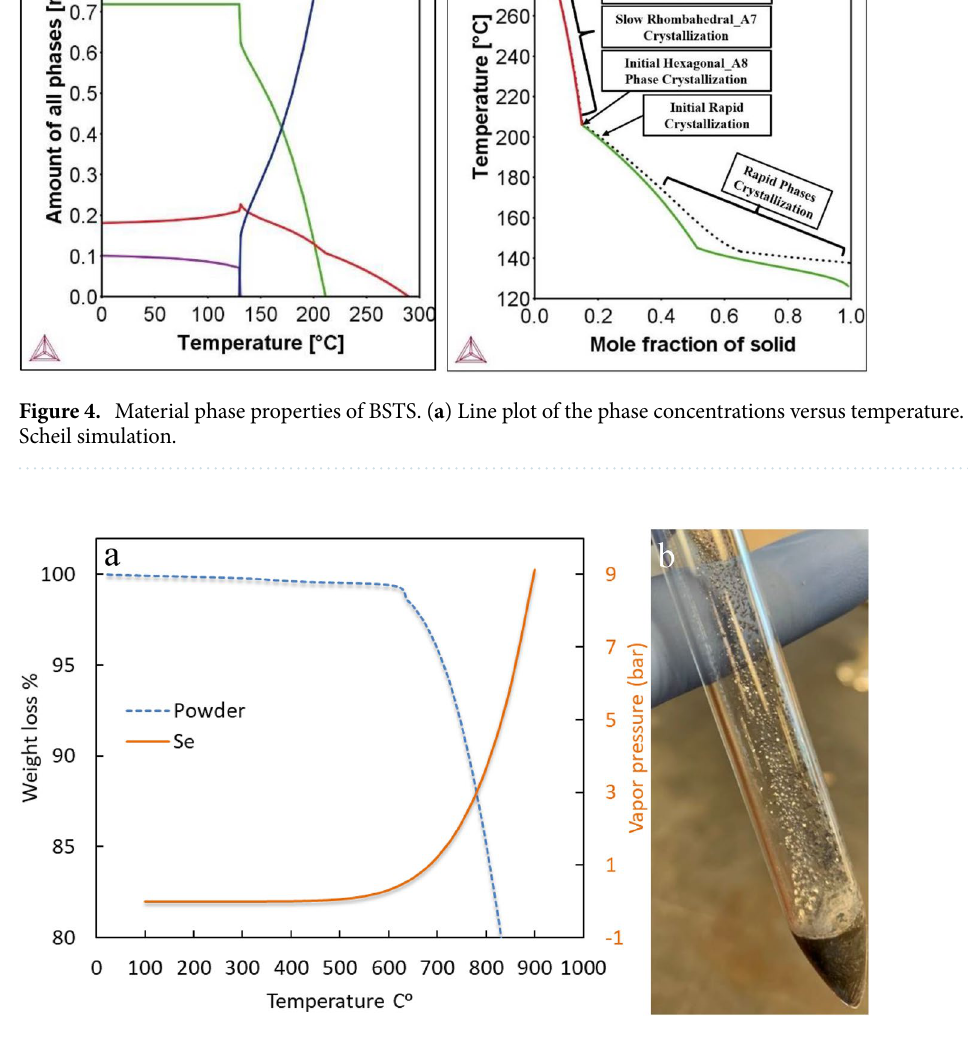
Figure 5. BSTS TGA of a synthesized sample. ( a ) BSTS TGA weight loss of material versus Se vapor pressure. ( b ) Synthesized BSTS